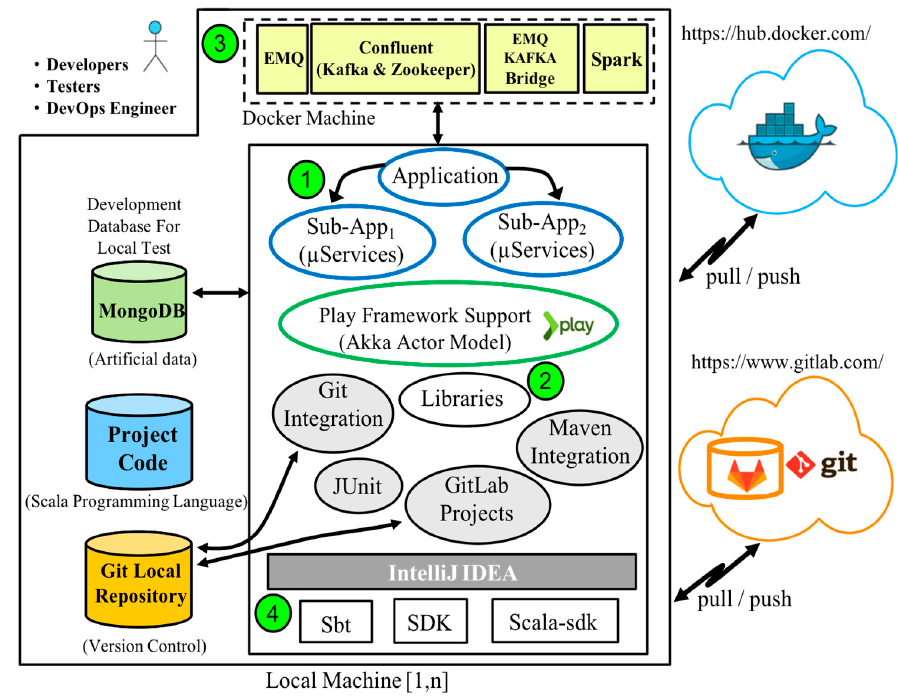
Figure A1. Detailed development view.